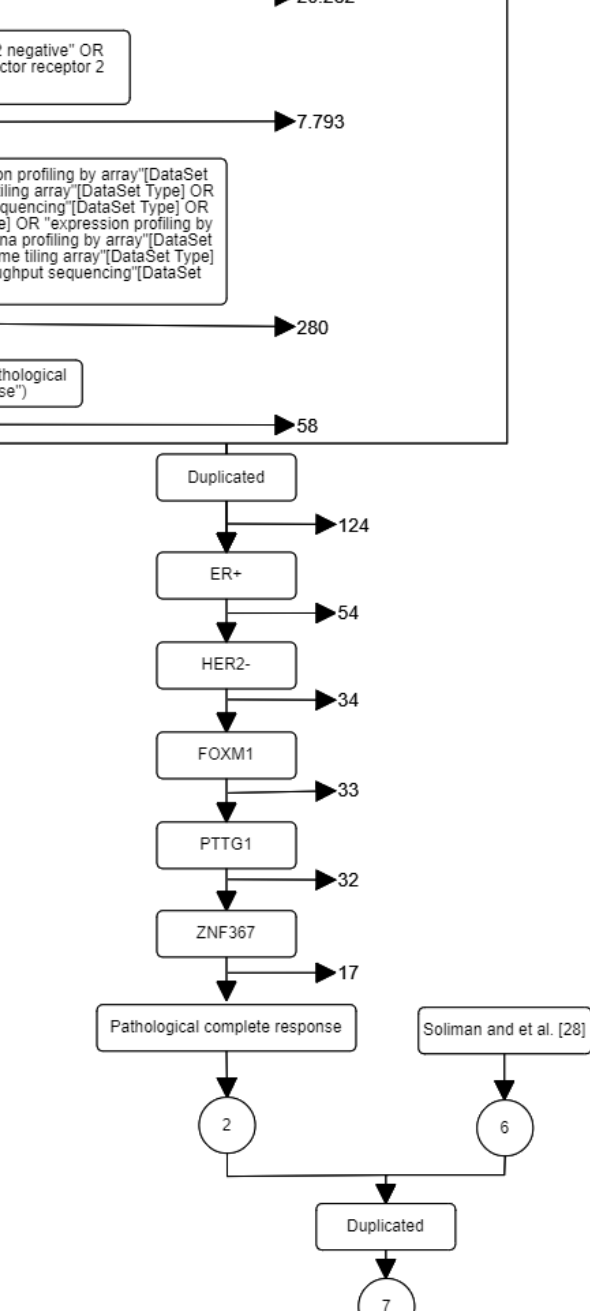
Figure 1. A systematic search for breast cancer datasets. Left path corresponds to GEO search. Right path corresponds to related papers